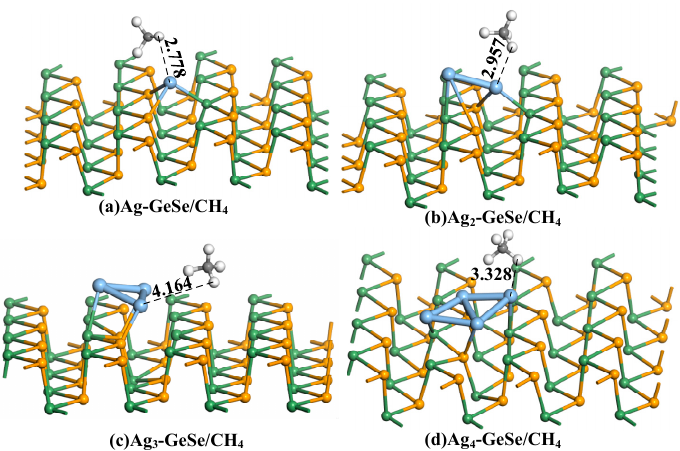
Figure 6. The most stable structures of gas molecules on Ag n -GeSe. ( a ) Ag-GeSe/CH 4 ( b ) Ag 2 - GeSe/CH 4 ( c ) Ag 3 -GeSe/CH 4 ( d ) Ag 4 -GeSe/CH 4 . GeSe/CH 4 ( c ) Ag 3 -GeSe/CH 4 ( d ) Ag 4 -GeSe/CH 4